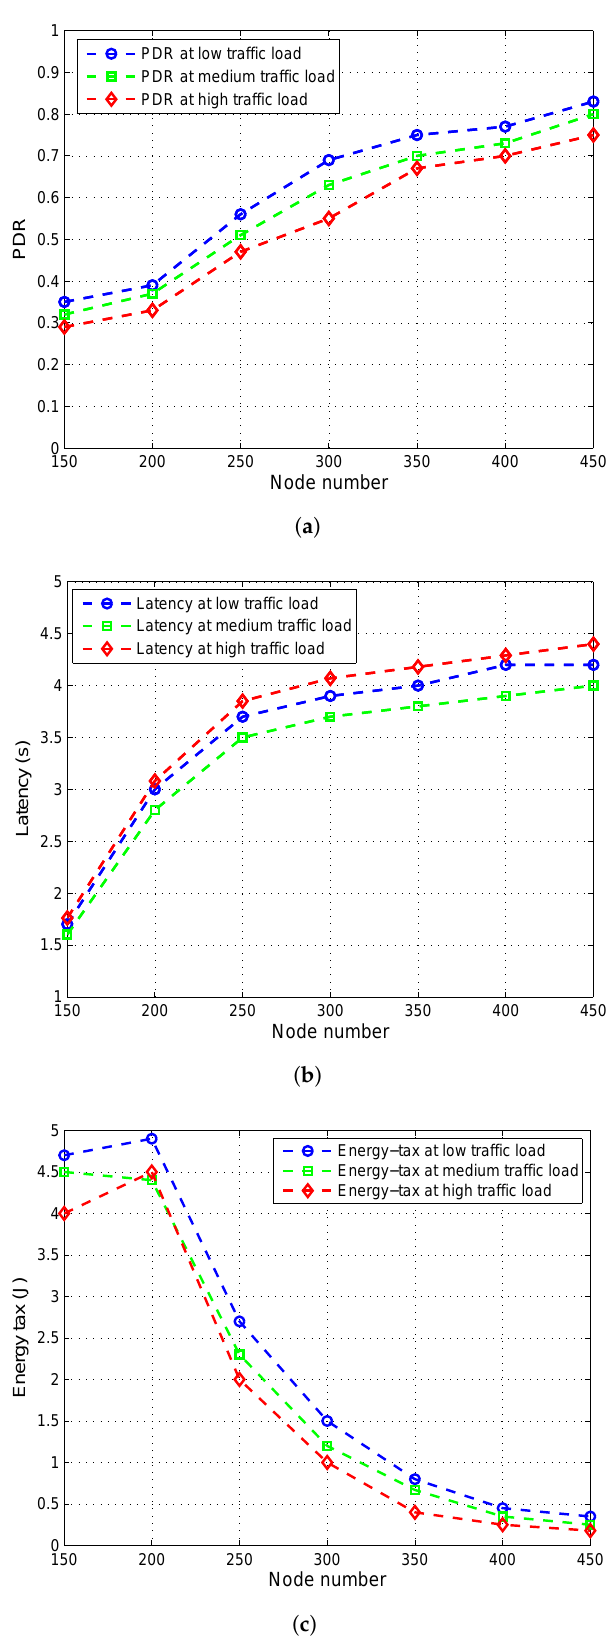
Figure 13. Performance parameters for GDGOR-IA. ( a ) PDR for GDGOR-IA; ( b ) latency for GDGOR-IA; ( c ) energy tax for